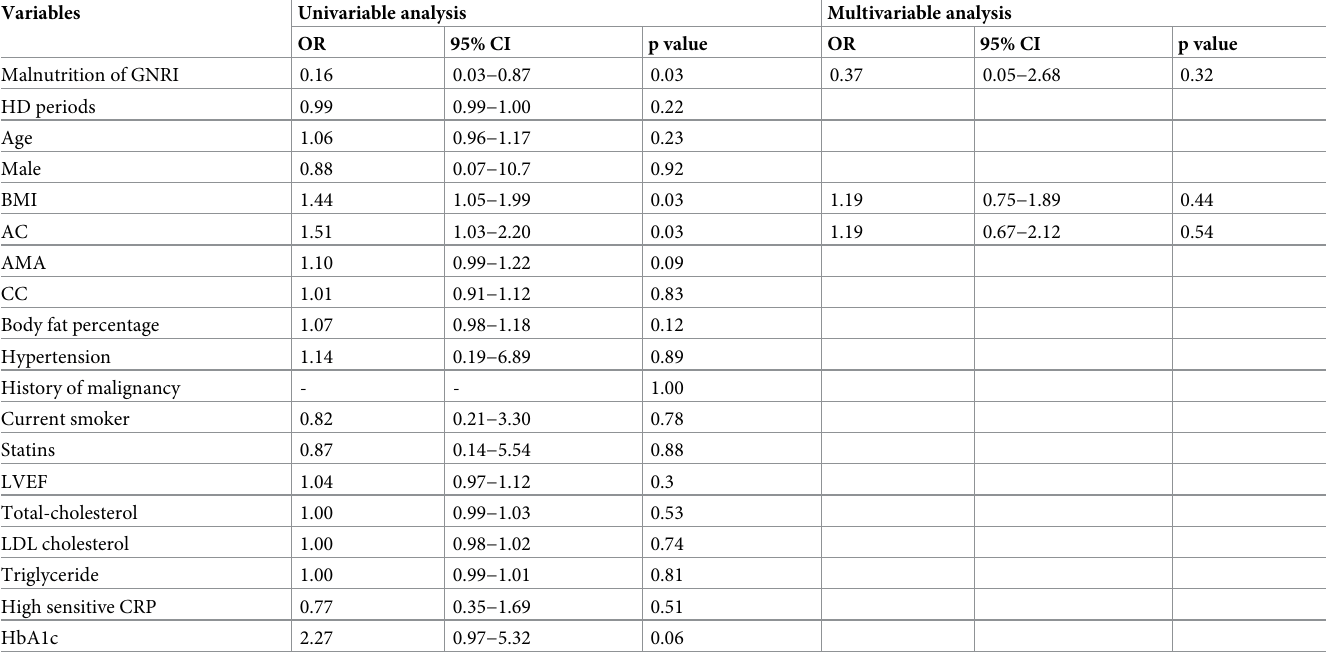
Table 7. Predictors of progression of lipid